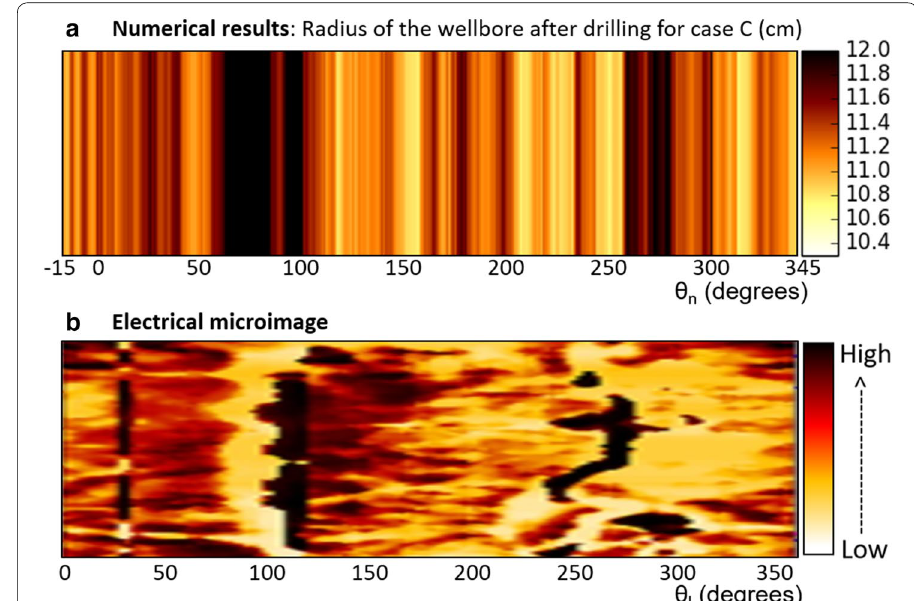
Fig. 12 Confrontation of the numerical results and of the logging images. a Numerical results were transformed to logging‑like images. The color intensity corresponds to the distance between the boundary of the wellbore and the center of the wellbore, after drilling, for case C, with zero fluid pressure in the wellbore. θ n is the angle measured from the direction of maximum stress. b Electrical microimage (extracted from the image presented in Fig. 2). The azimuthal origin for numerical results was adjusted manually for qualitative comparison ( θ l and θ n scales have not the same origin)